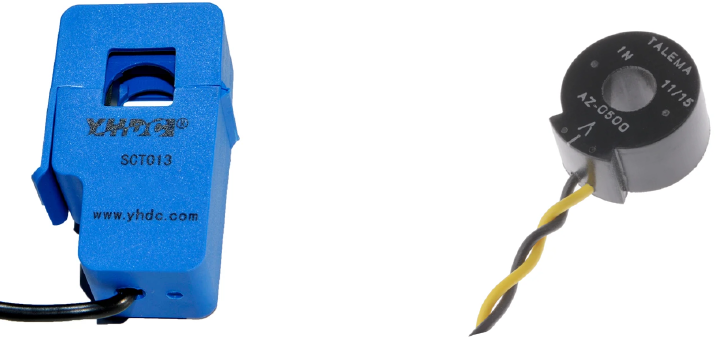
Figure 4. Sensors used in this work: ( Left side ) YHDC SCT-013-010. ( Right side ) Talema